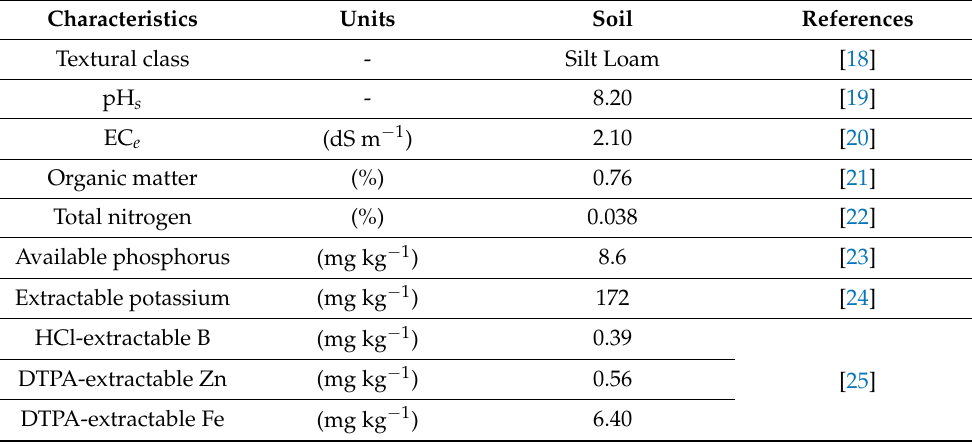
Table 1. Pre-transplantation soil